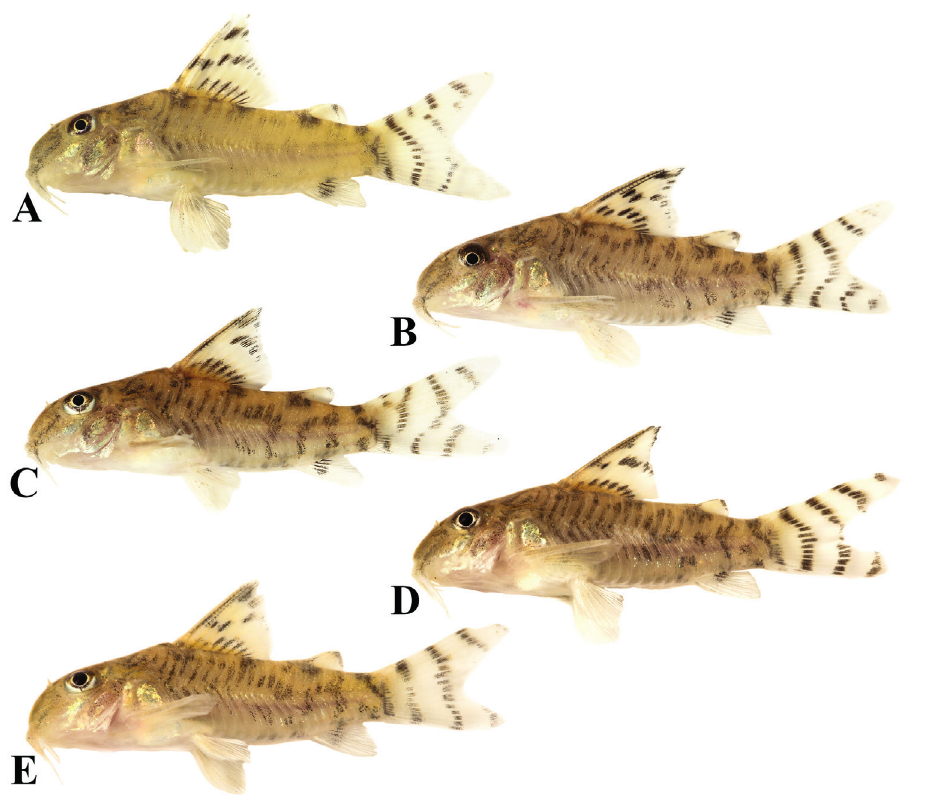
FIGURE 9 | Paratypes of Corydoras hypnos photographed alive, showing general color pattern and morphology in lateral view in ( A ) INPA 59775, 26.2 mm SL, ( B ) INPA 59775, 27.2 mm SL, ( C ) INPA 59775, 22.2 mm SL, ( D ) INPA 59774, 28.2 mm SL, and ( E ) INPA 59774, 22.6 mm SL, all from the rio Jamanxim, rio Tapajós basin, Pará State,